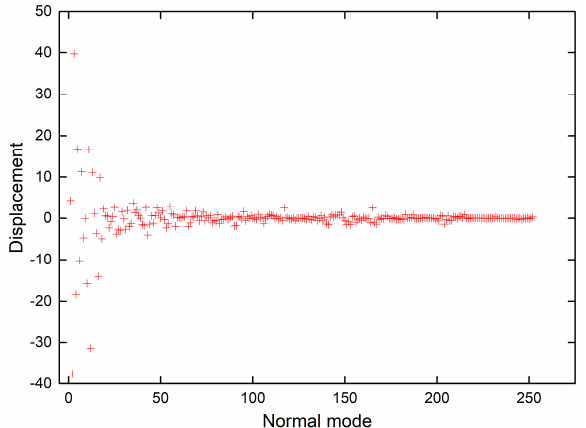
Figure 7. Shift vectors of chlorophyll a normal modes calculated using B3LYP functional, 6-31G(d) basis